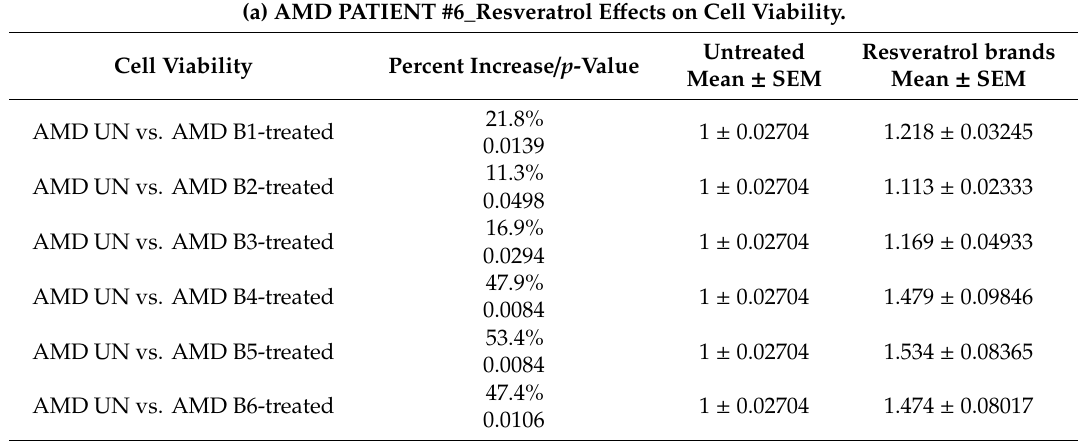
Figure 8. Effects of resveratrol formulations on cell viability ( A ) and ROS levels ( B ) in AMD patient